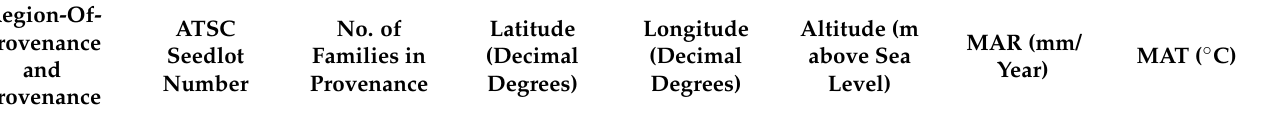
Table 1. Geographic, climatic and CSIRO Australian Tree Seed Centre (ATSC) family composition data for provenances included in the E. polybractea trial at West Wyalong established in 2016. Climate data were accessed from the Bureau of Meteorology (BoM) (Australia) http://www.bom.gov.au/climate/. accessed on 17 June